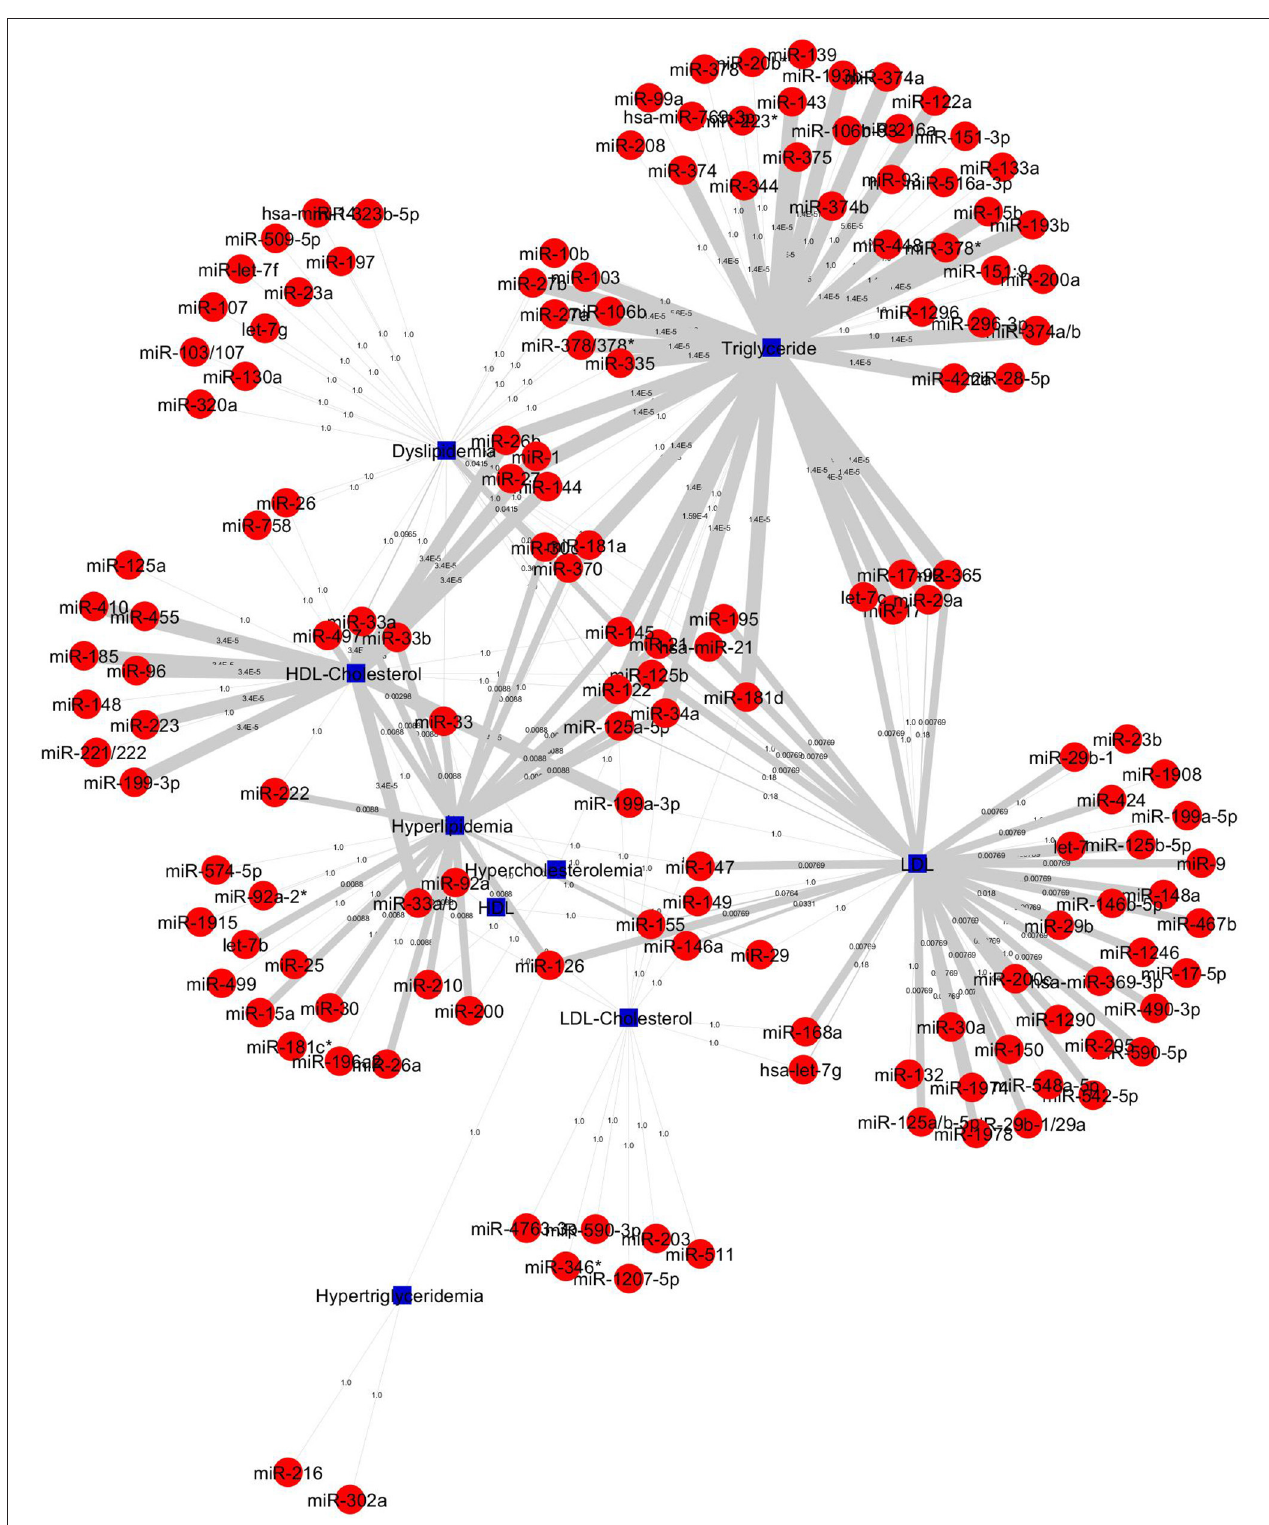
FIGURE 5 | All 227 miRNA-lipid disease associations by P -values. Red circles and green circles represent miRNAs and diseases, blue square represents lipid diseases/identifiers, respectively, according to the number of corresponding text mined annotated papers. Each linked pair represents a miRNA-disease association with edge-weighted measurement by P -values to visualize the strength of the miRNA-disease association. The miRNAs either connect one disease or more than one disease; it shows that a single miRNA or group of miRNAs may be involved with one or more than one disease.